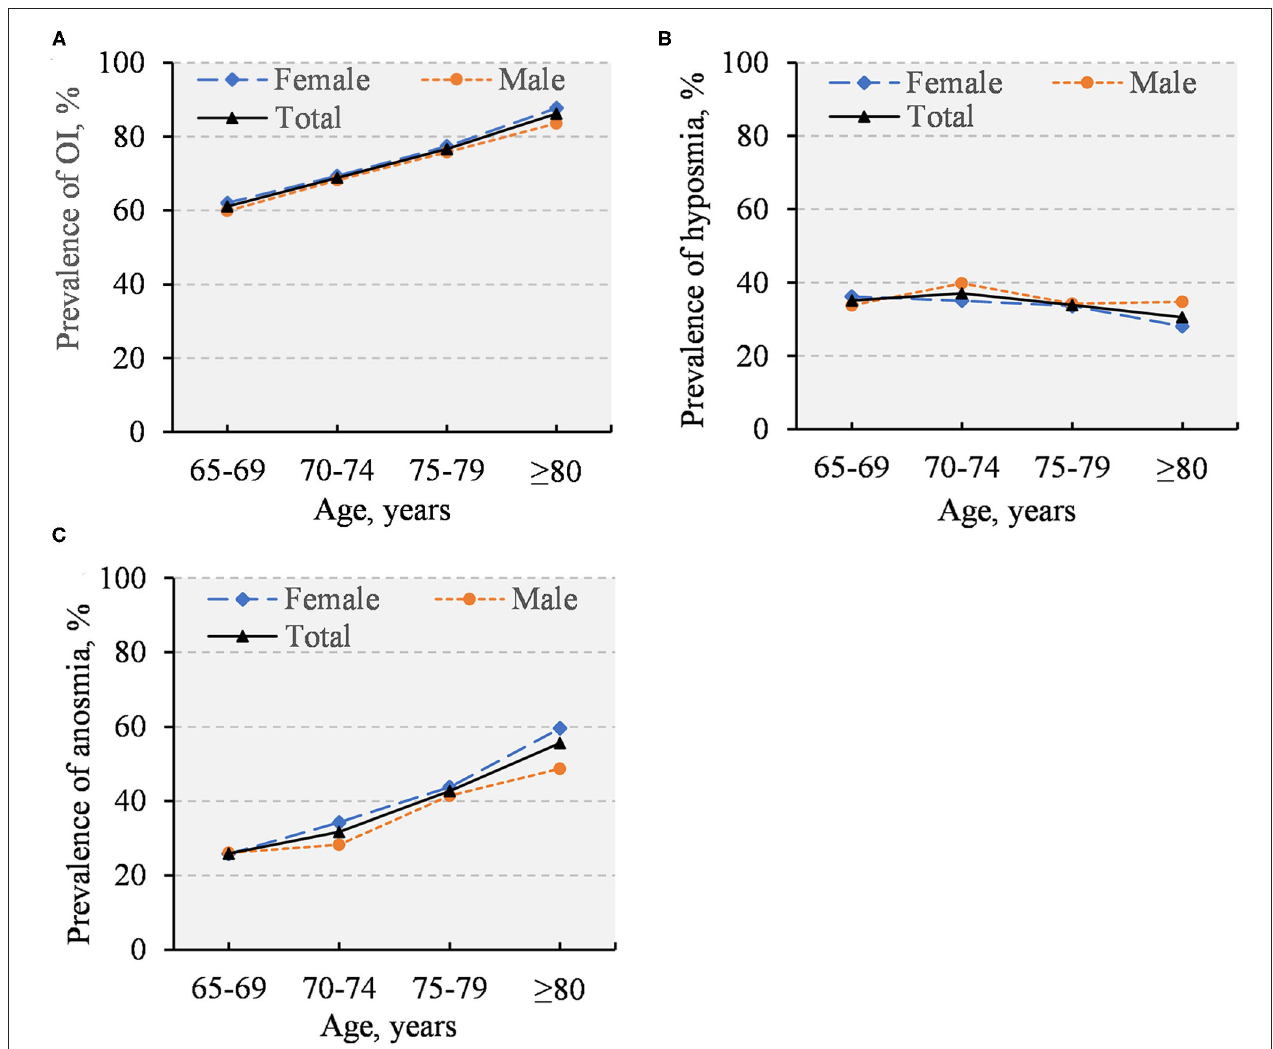
FIGURE 1 | Prevalence of olfactory impairment (A) , hyposmia (B) , and anosmia (C) by age and sex ( n = 4,514).